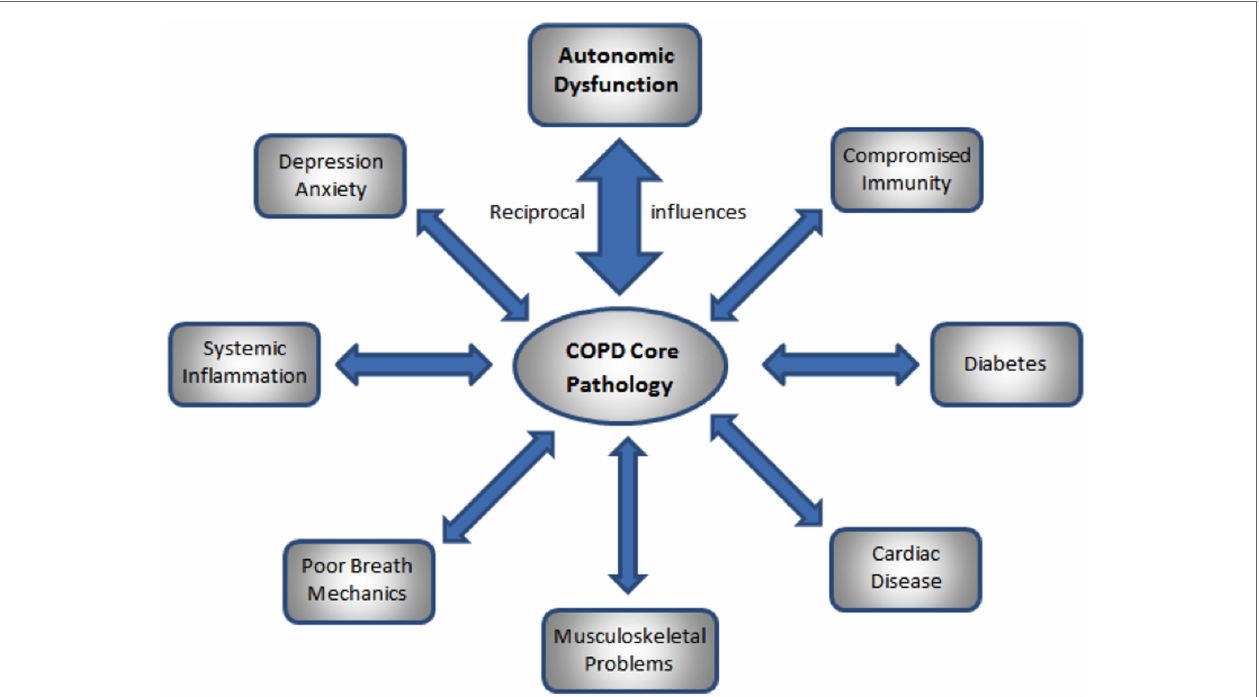
FIGUrE 1 | reciprocal influences of core coPD pathology and the co-morbidities of coPD